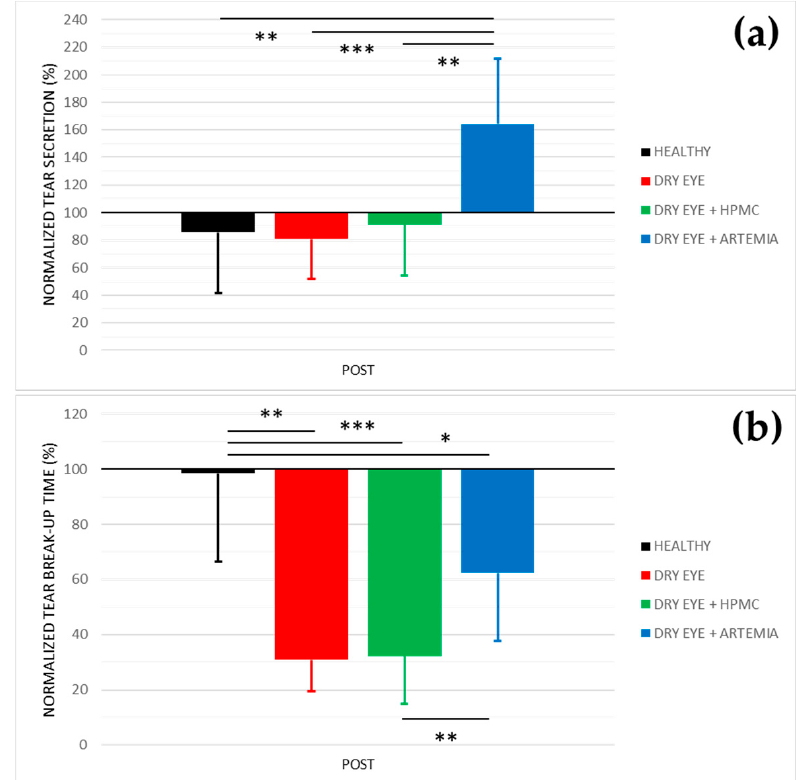
Figure 1. Normalized effect on tear secretion ( a ) and tear break − up time ( b ) of the instillation of the different treatments for 5 consecutive days. The values higher or lower than 100% represent an increase or decrease in comparison with their baseline, respectively. The statistical comparison was performed between the different groups ( n = 5, each group). * p < 0.05, ** p < 0.01, *** p < 0.001, Student’s t − test for independent samples.